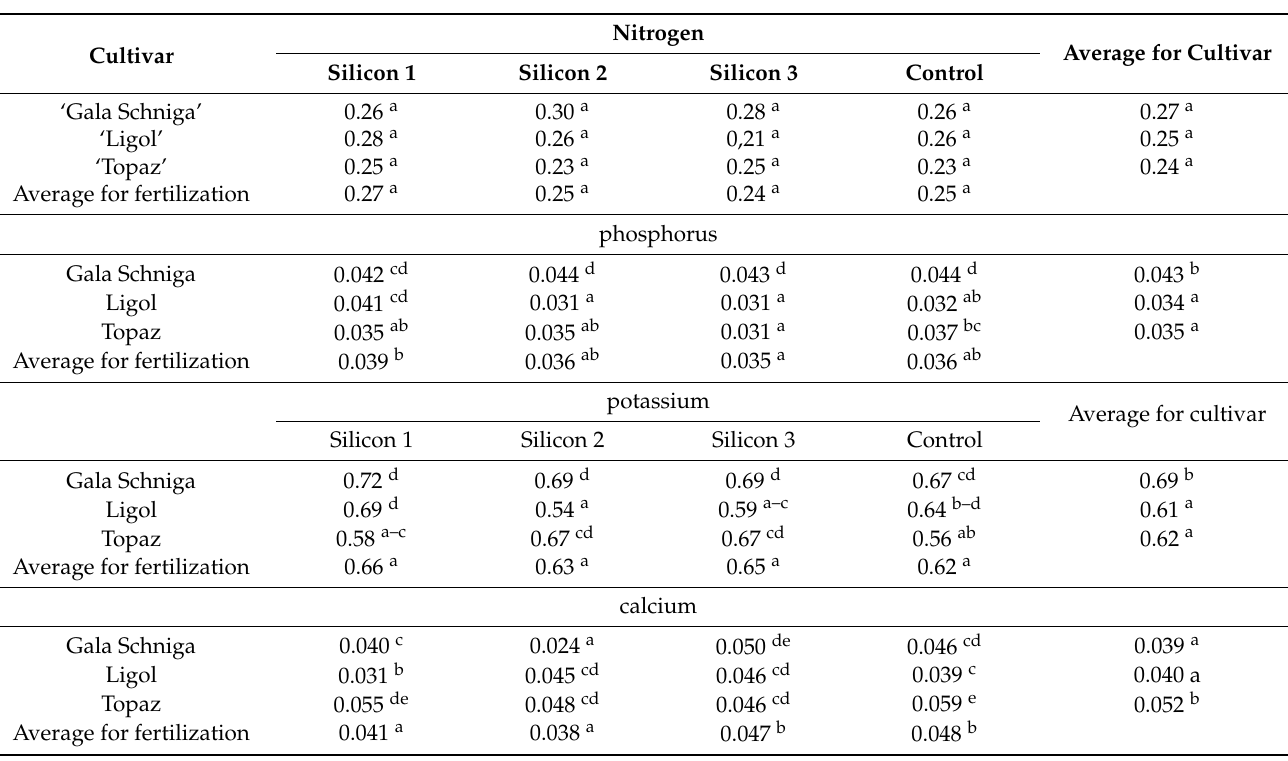
Table 15. The content of macronutrients in fruits of apple trees depend on cultivar and foliar silicon treatment